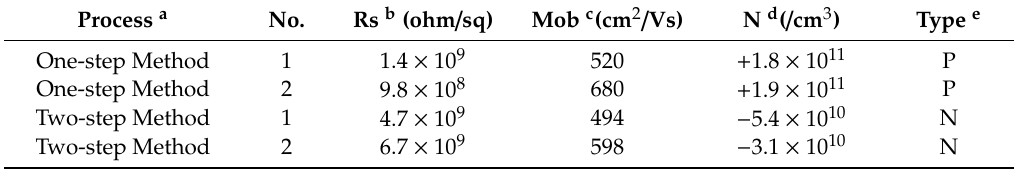
Table 1. Hall e ff ect parameters with one-step and two-step